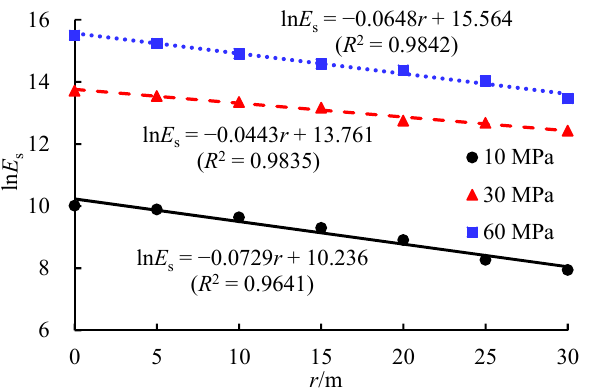
Figure 8. Regression analysis of blasting seismic energy attenuation with distance under varied hydrostatic in situ stress levels.